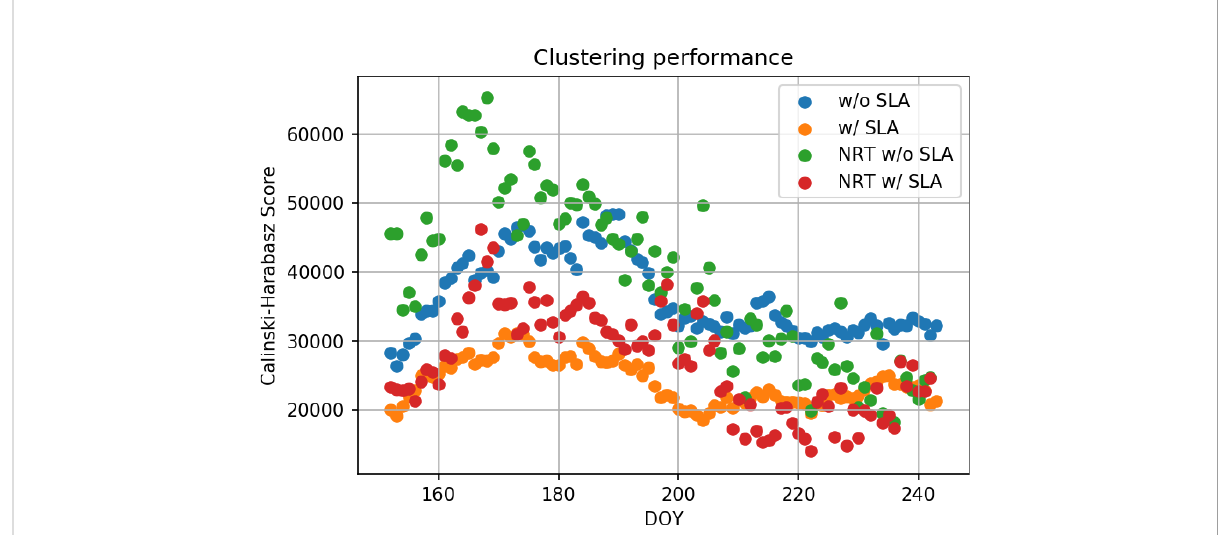
FIGURE 7 Average clustering performance over the seasonal cycle, showing clustering models with and without the inclusion of SLA data, as well as the application to NRT data for both these